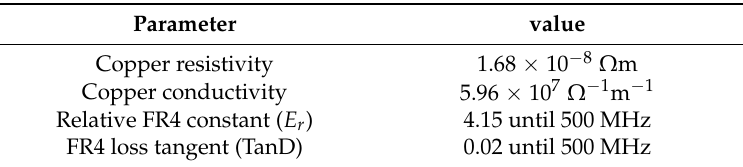
Table 5. FR4 and conductor: copper parameters.